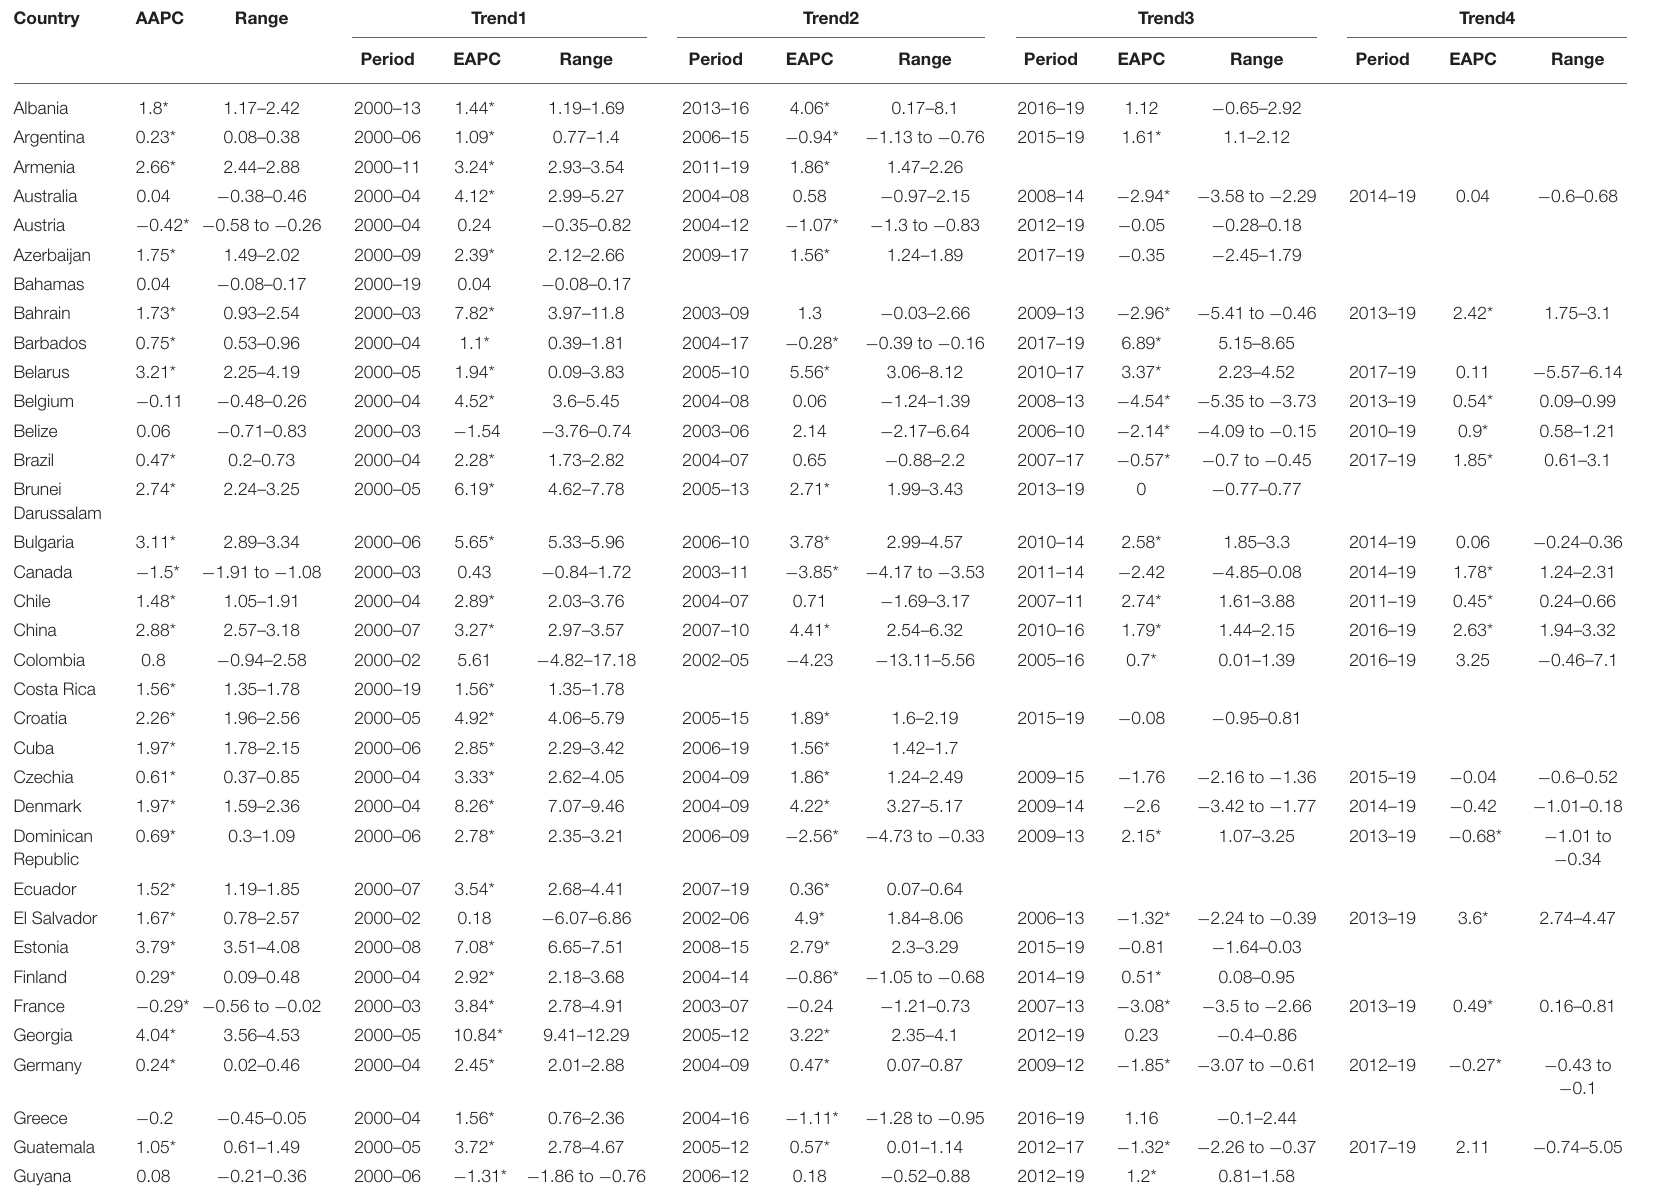
TABLE 3 | Trend analysis of age-standardized incidence for prostate cancer from 2000 to